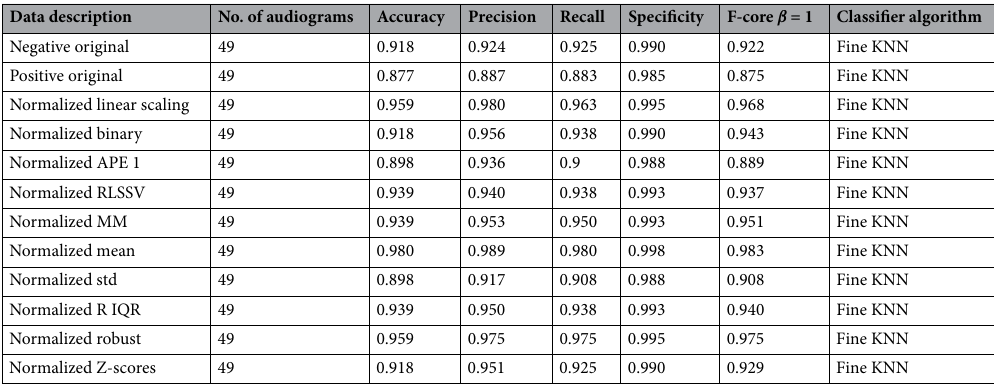
Table 3. Classification performance of each normalized data